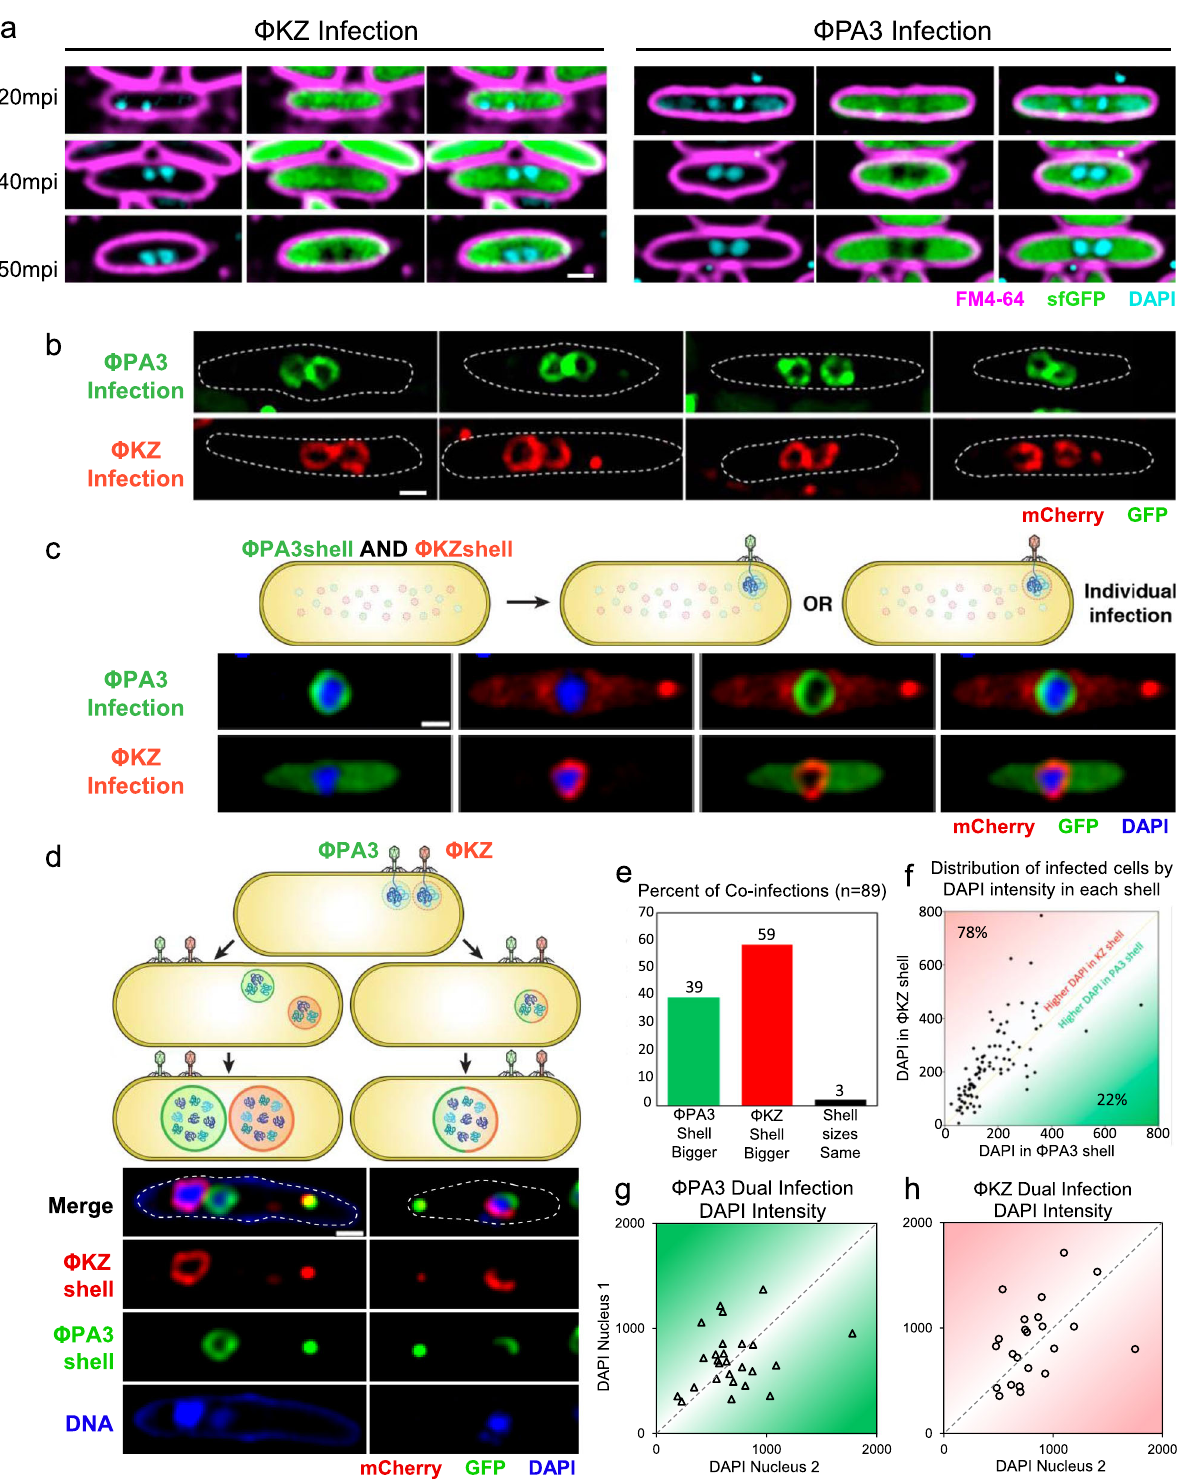
Fig. 1 Subcellular Genetic Isolation occurs between identical and divergent co-infecting phages. a P. aeruginosa infected for 50 min with either Φ PA3 or Φ KZ frequently harbors more than one phage nucleoid. Cell membranes (magenta), DNA (cyan), GFP (green). b GFP-tagged Φ PA3 shell (green) and mCherry-tagged Φ KZ shell (red) reveals two nucleoids separated by nuclear shells at 50 mpi. c , d Cells expressing both GFP- Φ PA3shell and mCherry- Φ KZshell and were infected with either Φ PA3 or Φ KZ ( c ) or both phages ( d ). c GFP- Φ PA3shell only forms a shell (green) when infected with Φ PA3 and mCherry- Φ KZshell only forms a shell (red) when infected with Φ KZ. Phage DNA (blue). d Co-infected cells formed two separate red and green nuclei (~75%) or one nucleus with both red and green shell components (~25%). e – h n = 89 co-infected cells, e Percentage of co-infected cells with a larger Φ PA3 or Φ KZ shell. f Distribution of co-infected cells based on DAPI intensity inside shells. g , h Distribution of single-species co-infecting nuclei by DAPI intensity for Φ PA3 or Φ KZ, respectively. Using a cut off of at least 5% difference between the two values to establish if they are different from one another shows that 88% of the nuclei have unequal DNA content. Source data are provided as a Source Data fi le. Scale bars in panel a – d equals 1 μ m. NATURE COMMUNICATIONS| (2021) 12:342